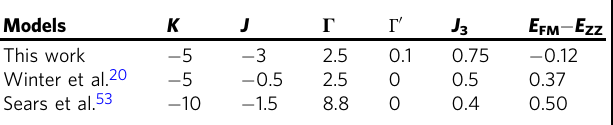
Table 1 Classical energy of ferromagnetic state with respect to zigzag state for representative model parameters (all energies in meV).